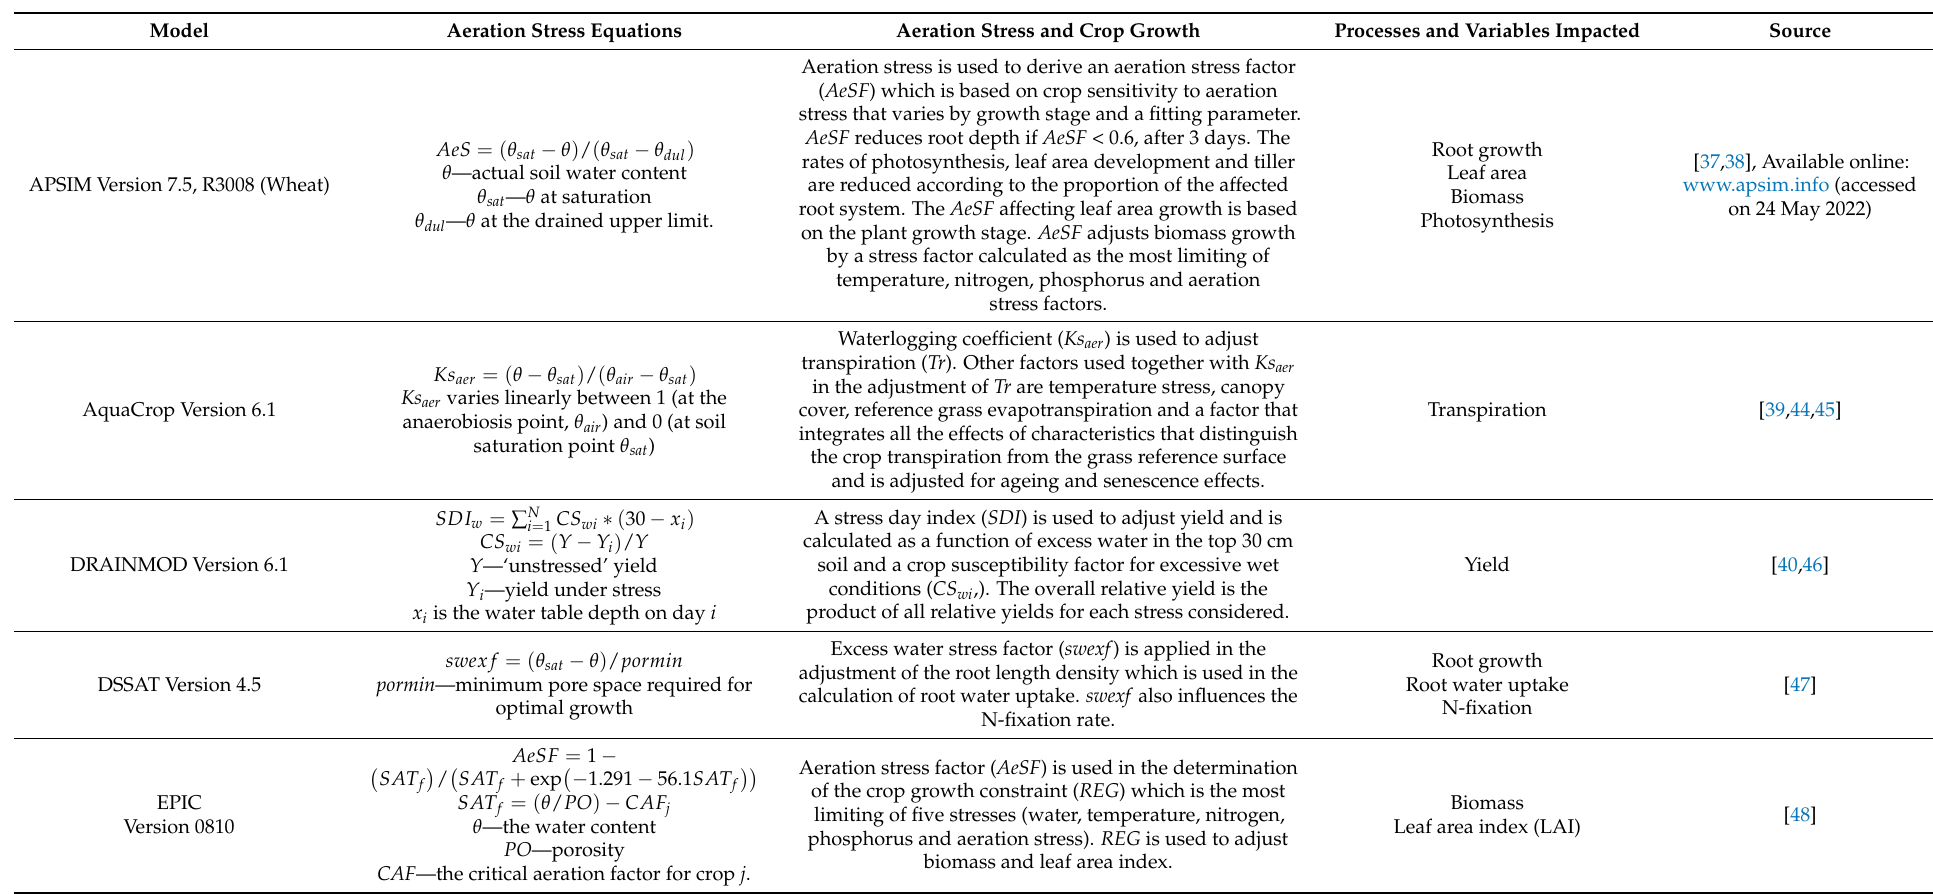
Table 1. Aerations stress descriptions in crop models, and processes and variables directly